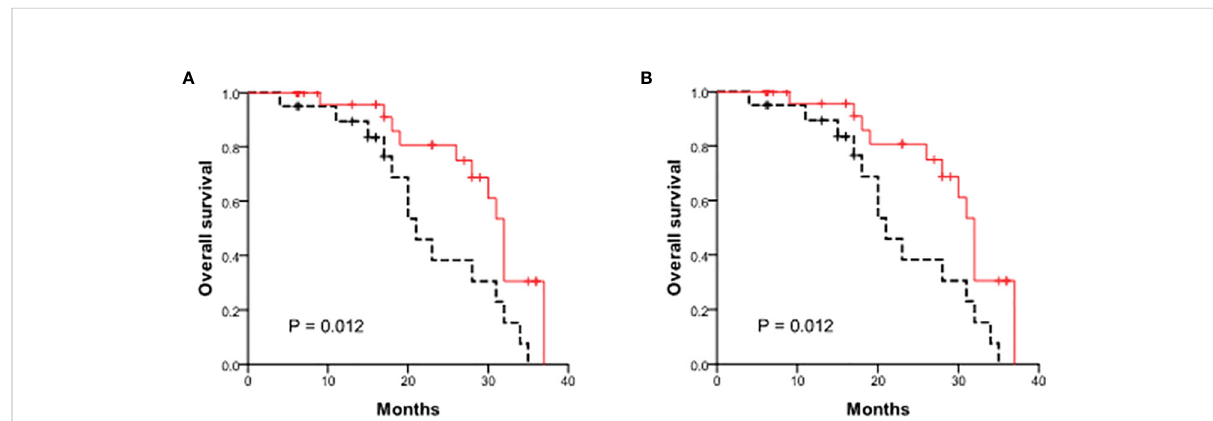
FIGURE 2 Comparison of patient survival between patients with high and low levels of serum exosomal miR-200c-3p. (A) Tumor-free survival curves; (B) The overall survival curves.